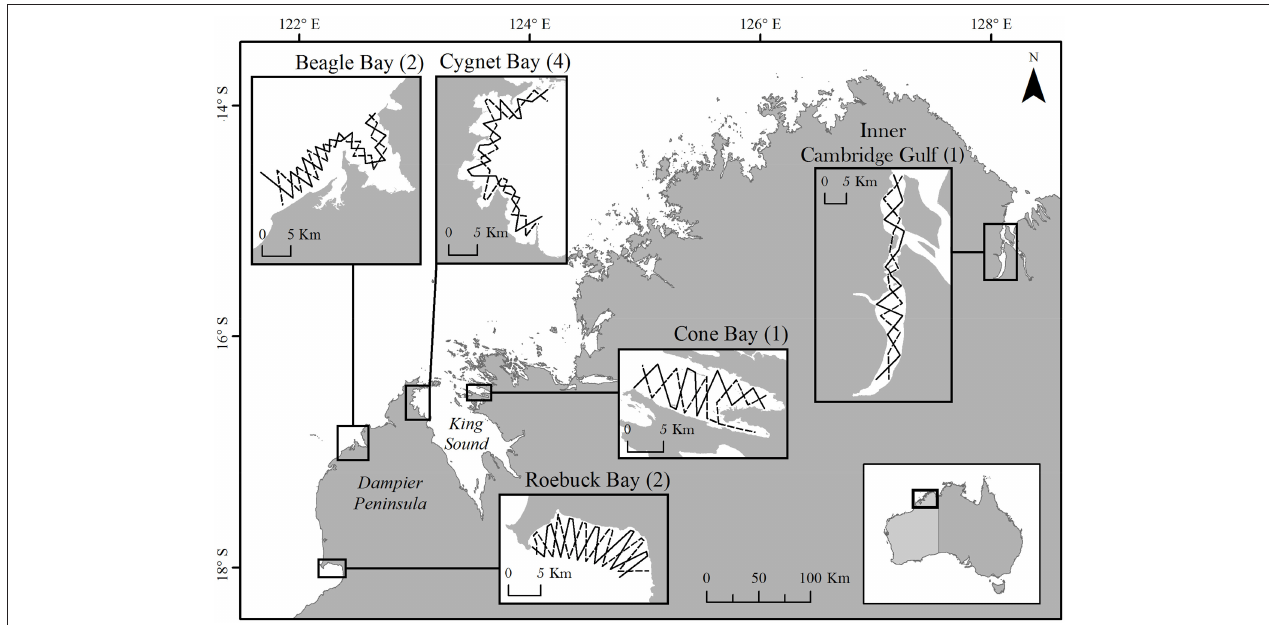
FIGURE 1 | The Kimberley coastline of north-western Australia, showing study site locations. Numbers in parentheses indicate the number of sampling periods at each site. Only a single sampling period was conducted at Cone Bay and the Inner Cambridge Gulf due to resource limitations and very low encounter rates of dolphins, respectively. Insets show the two opposing pre-determined transect routes at each site. The coastline illustrated corresponds to the highest astronomical